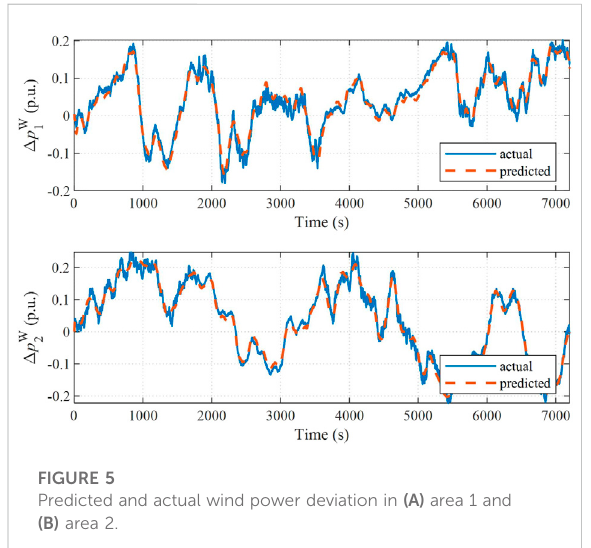
FIGURE 5 Predicted and actual wind power deviation in (A) area 1 and (B) area 2.